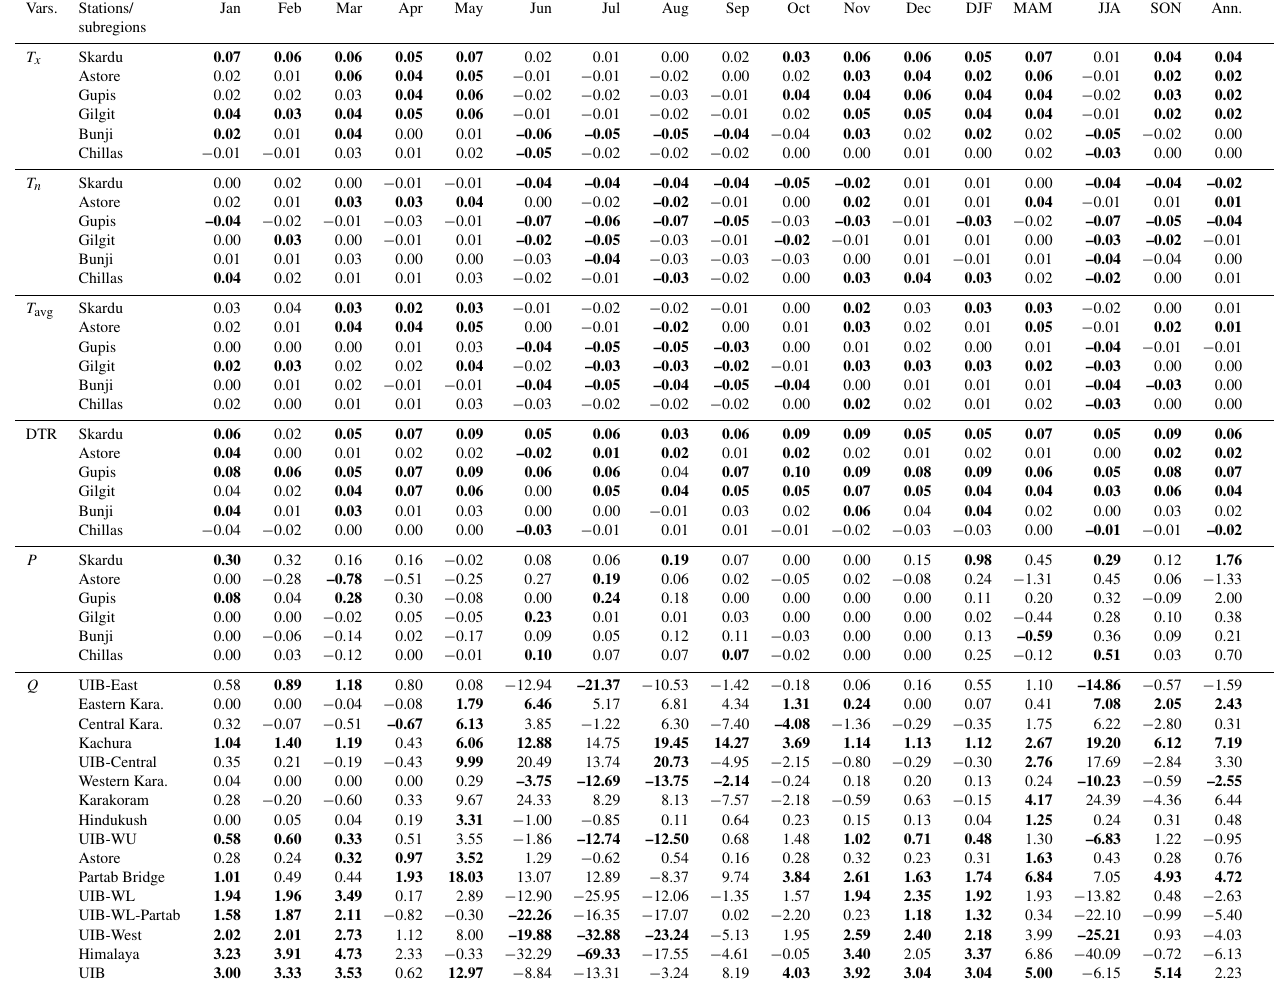
Table 6. Long-term trends (1961–2012) in T x , T n , T avg , DTR and P at monthly to annual timescales in respective units as given in Tables 4 and 5. Note: “Kara” refers to